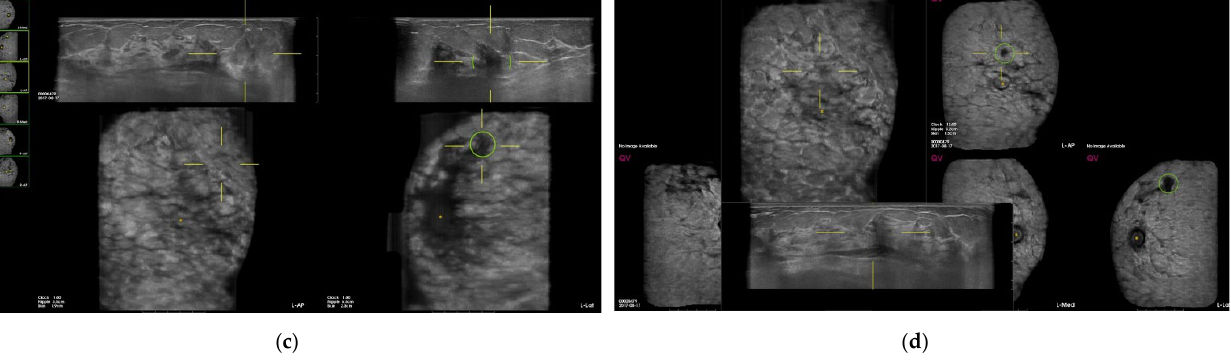
Figure 2. Screening automated breast ultrasound (ABUS) of a 45-year-old woman reveals false-positive marks due to shadowing. ( a ) CAD-based minimum intensity projection (MinIP) of an ABUS scan of the AP, medial, and lateral sides of both breasts. There are three dark spots with green circles. ( b ) The lesion showing a dark spot with a green circle on AP side of the right breast confirms the pseudolesion due to periareolar shadowing in the transverse scan. ( c , d ) The lesion showing a dark spot with a green circle on AP side of the left breast confirms the pseudolesion due to Cooper’s ligament shadowing in the transverse scan. The lesion showing a dark spot with a green circle laterally on the left breast confirms the pseudolesion due to marginal shadowing in the transverse scan.